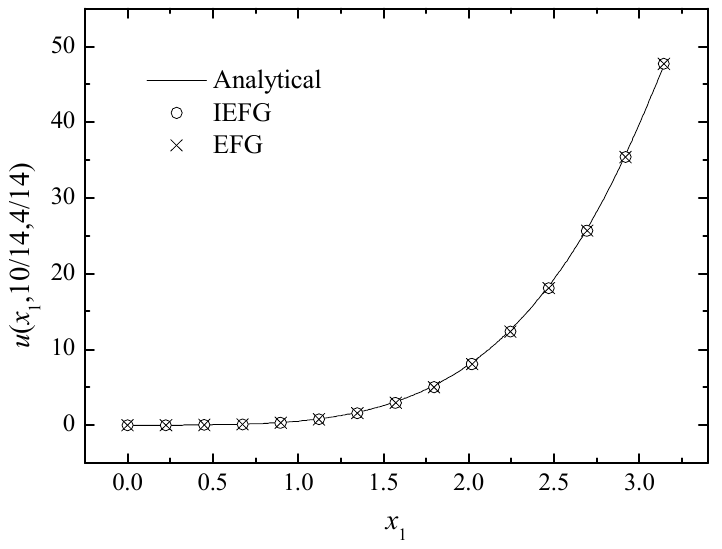
Figure 3. The comparison of the numerical and analytical solutions of the two methods along the x 1 -axis.